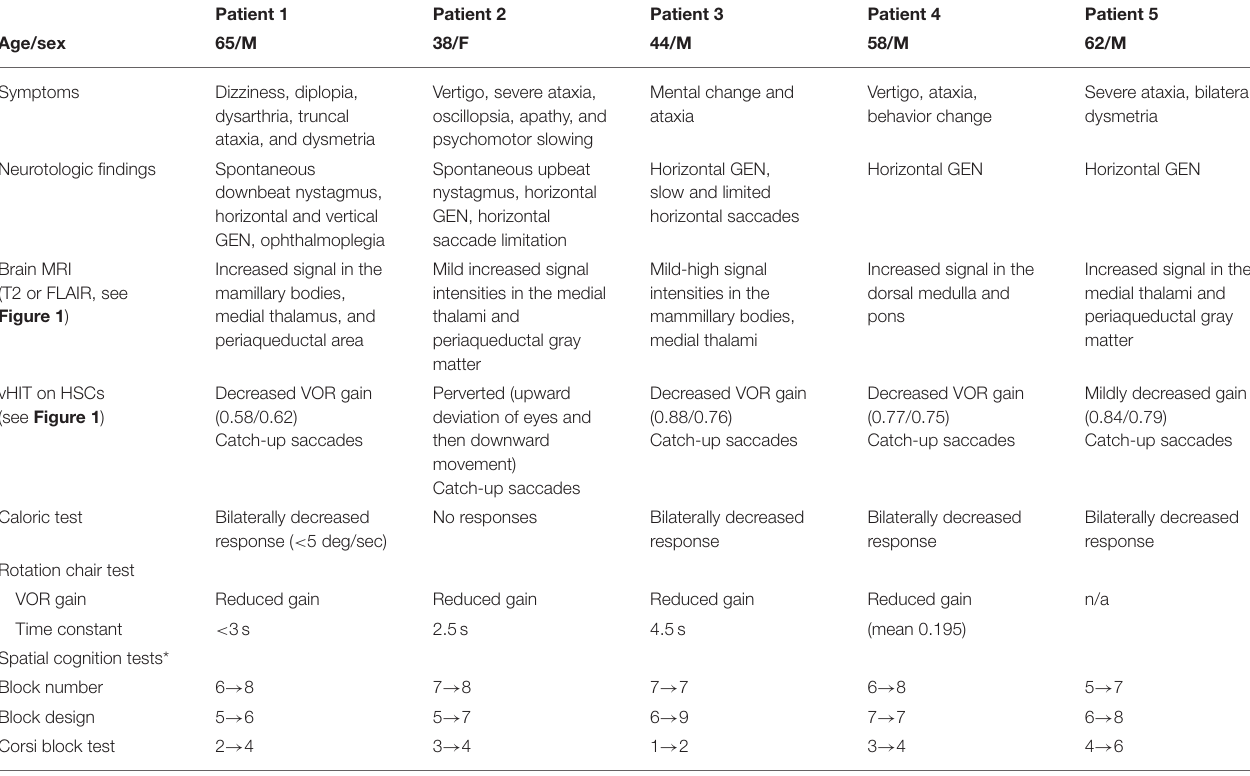
TABLE 1 | Clinical findings of five cases with Wernicke’s